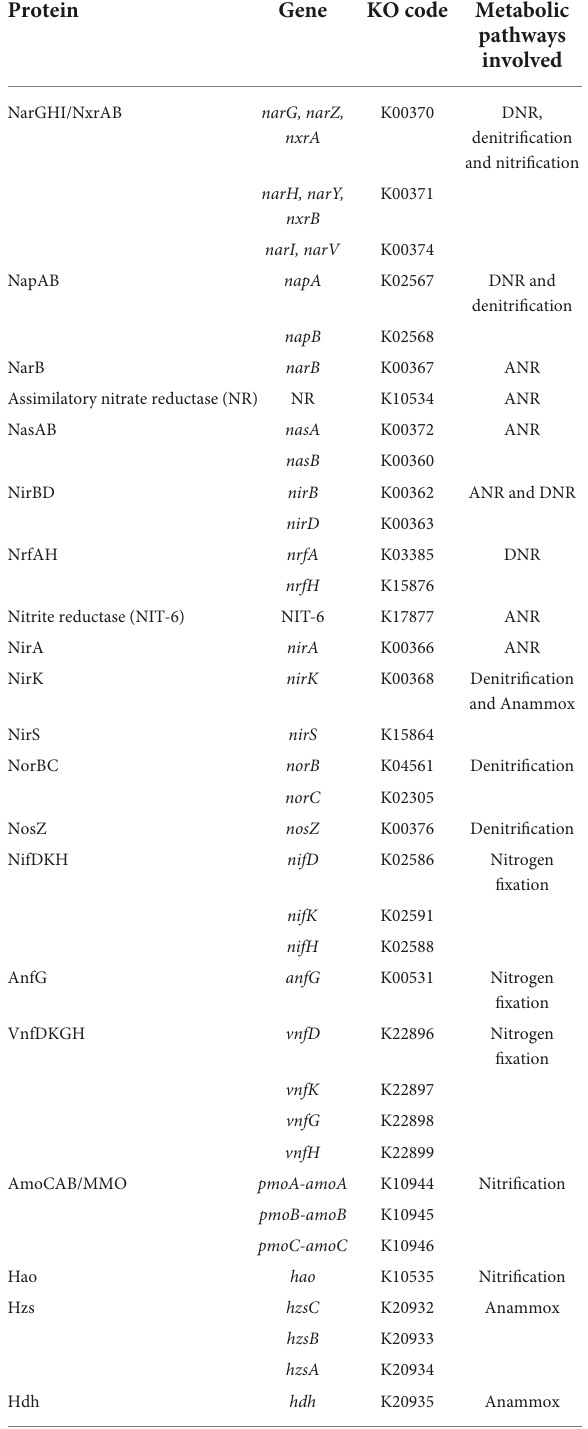
TABLE 1 Summary of the nitrogen-cycle pathways available on the Kyoto encyclopedia of genes (KEGG) database. Protein Gene KO code Metabolic